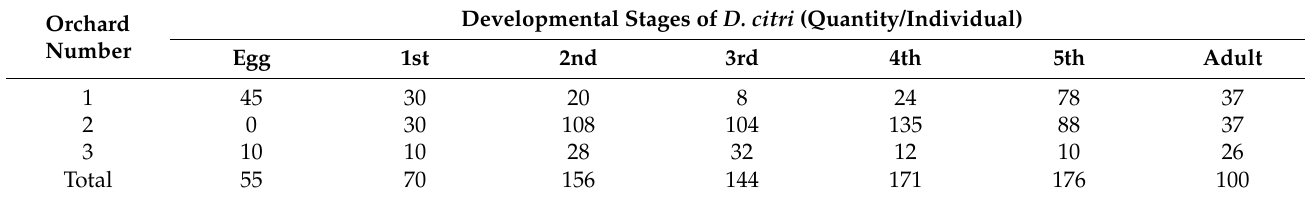
Table A2. Information on D. citri samples collected from three citrus orchards.